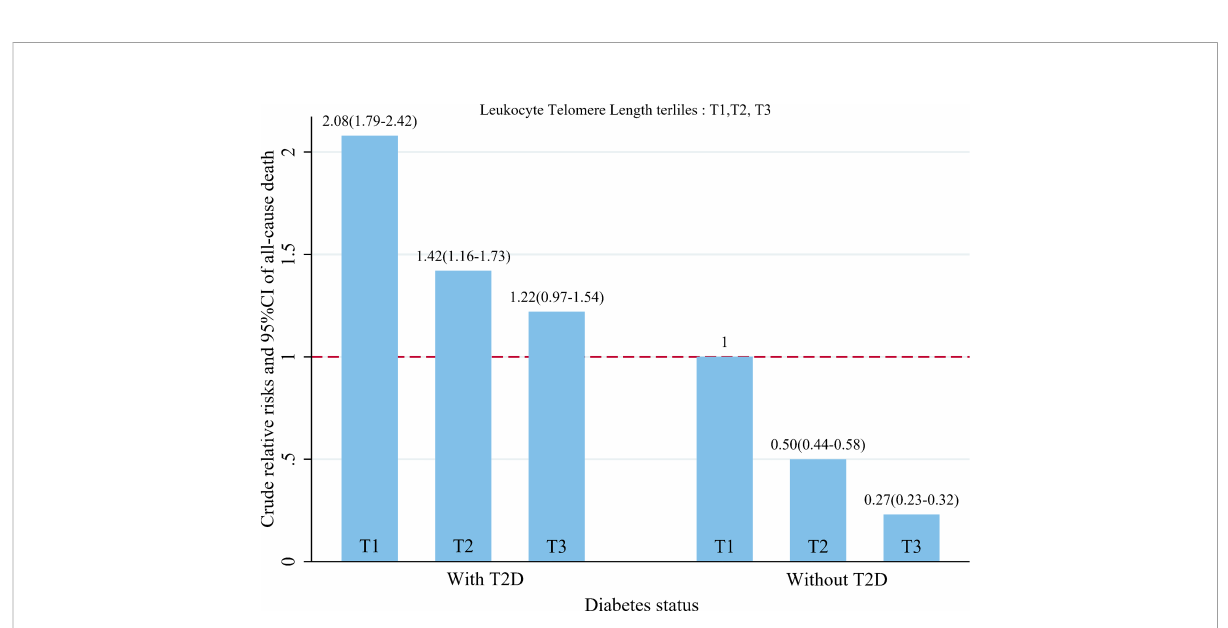
FIGURE 3 Dose – response relationship between baseline leukocyte telomere length quartiles and crude hazard ratios and 95%CI of all-cause death, strati fi ed by status of T2D.